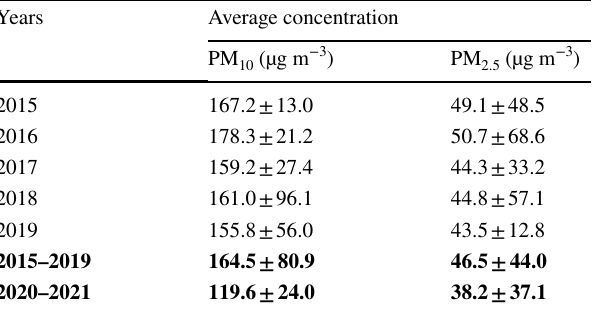
Table 5 Annual PM 10 and PM 2.5 mean concentrations during the pre-pandemic period (2015–2019) and during the COVID-19